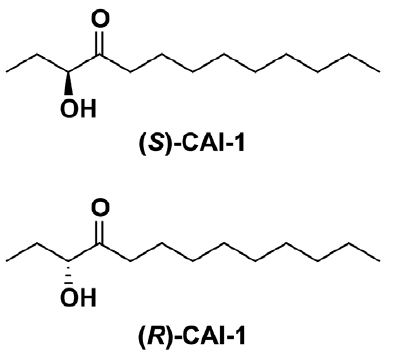
Figure 7. Structure of ( S )-CAI-1 produced by V.cholerae and its stereoisomer.